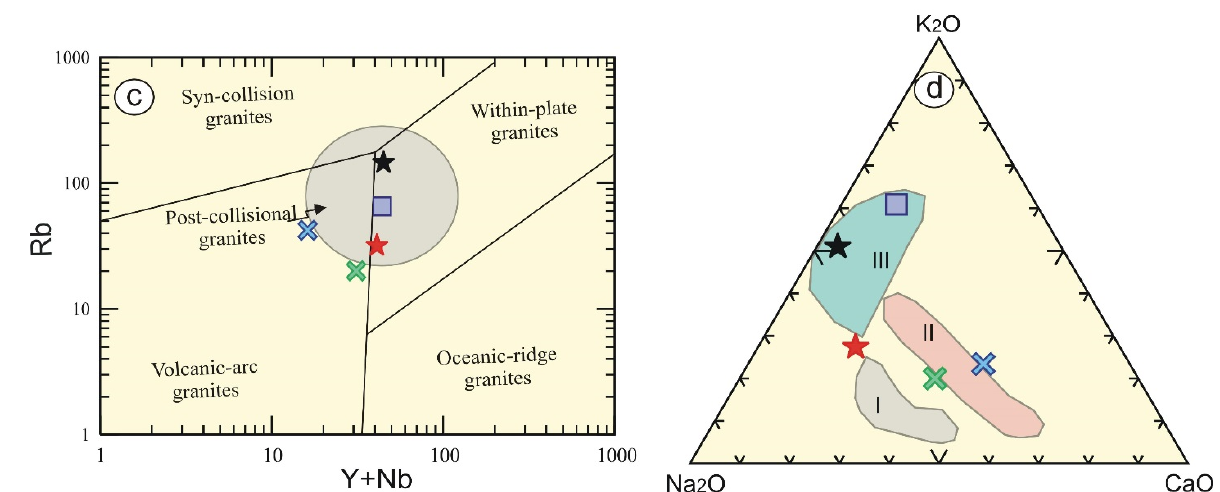
Figure 4. Multi trace elements pattern normalized to primitive mantle [23] for ( a ) tonalite-granodiorite and ( b ) alkali-feldspar granites, syenogranites, and albitized granites. Tectonic discrimination diagrams ( c ) Y + Nb versus Rb binary diagram [24], where post-collisional field is adapted from [25]; and ( d ) NKC diagram (Na 2 O-K 2 O-CaO) of the Egyptian granitoids [26], III = late (subphase) orogenic calc-alkaline phase, II = early subphase of younger granites, I = calc-alkaline diorite and metagabbro. Rock symbols as in Figure 3.